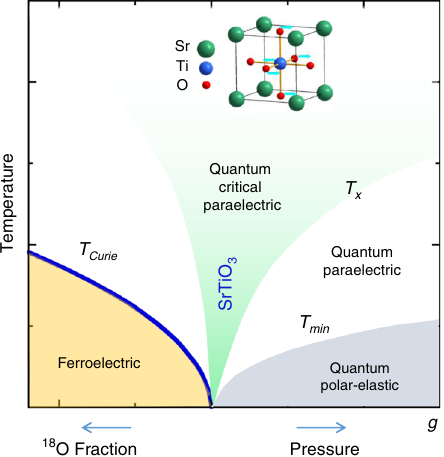
Fig. 1 The phase diagram of SrTiO 3 based on a quantum ϕ 4 self- consistent fi eld model of a displacive ferroelectric 3 . The vertical axis is the temperature while the horizontal axis represents a quantum tuning parameter, g , that can be varied, for example, by the application of hydrostatic pressure, isotopic substitution as in SrTi( 16 O 1 − x 18 O x ) 3 , or by chemical substitution as in the cases of Sr 1 − y Ca y TiO 3 and Sr 1 − y Ba y TiO 3 . In strontium titanate T Curie and T min are, respectively, of order 25 K at 0 kbar and x = 1, and 8 K at 10 kbar and x = 0. The green shaded region highlights the quantum critical regime, characterized by an approximately quadratic temperature dependence of the inverse dielectric function as seen experimentally in SrTiO 3 , 18 O substituted SrTiO 3 , KTaO 3 , and other materials. The curve T min marks the temperature of the minimum in the inverse dielectric susceptibility as observed and predicted by a model involving the electrostrictive coupling of polarization and strain and below which the system forms a quantum polar-elastic regime 3,S7 4 . An extension of the phase diagram would include an additional orthogonal axis representing the charge carrier density, n , of doped or injected electrons which gradually supresses ferroelectricity. The introduction of carriers results in the emergence of a dome of superconductivity mediated by longitudinal hybrid polar modes near to the quantum critical point under speci fi c conditions as observed in the model and experiments presented in the main